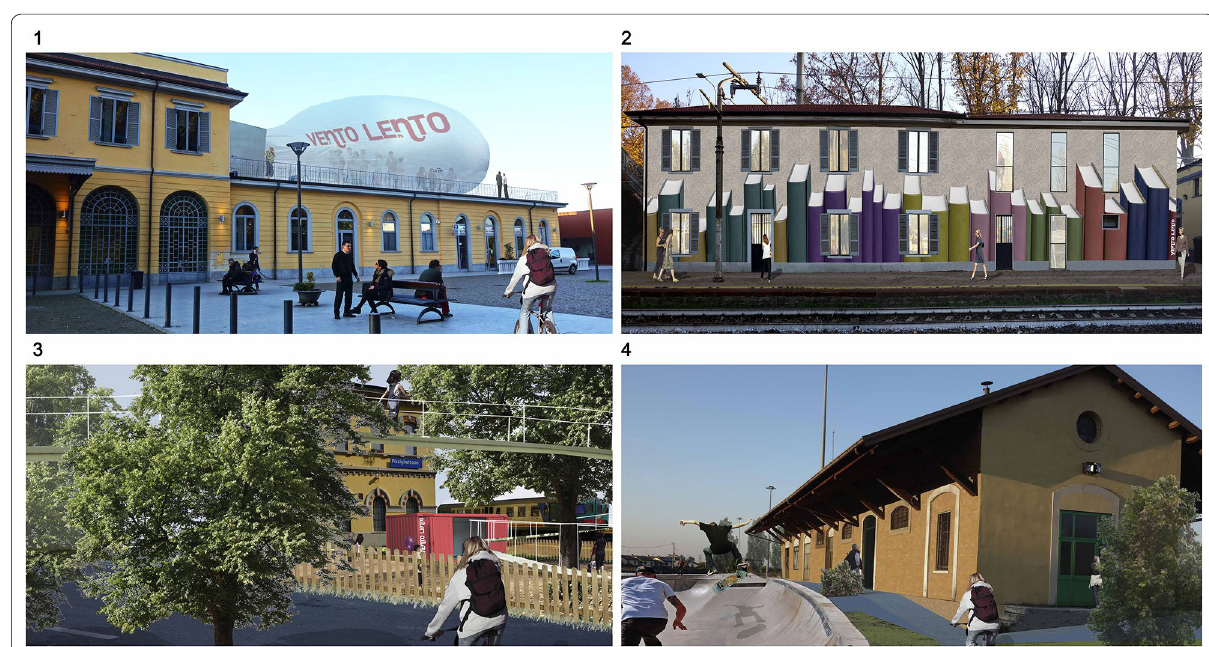
Fig. 9 Photomontages of the projects, showing the external regenerating aspect of stations (1. Tortona, 2. Codogno, 3. Pizzighettone, 4. Casalmag- giore)